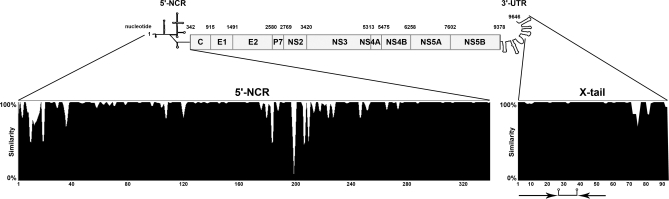
Nucleotide Similarities within HCV 5′- and 3′-Genome EndsTop panel: schematic representation of the HCV reference genome H77 as given in the 2008 LANL database.Bottom panel: Percent nucleotide identity along the 5′-NCR and the X-tail, as calculated by a sliding window analysis with VectorNTI software. Window size was 2 nucleotides. The alignment used for the sliding window analysis contained the complete HCV genotype reference panel (n = 60 sequences) from the LANL HCV database (available at http://hcv.lanl.gov/content/sequence/NEWALIGN/align.html) and all X-tail sequences available in GenBank as shown in Text S2, including the sequences determined de novo in this study (EU835523-EU835532).